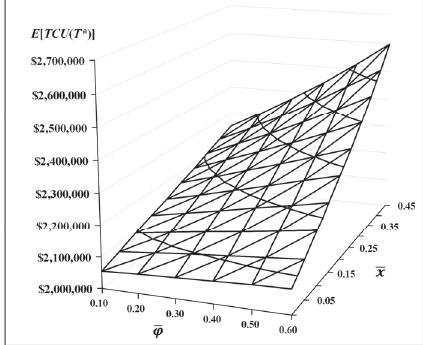
Fig. 11. The behavior of E [ TCU ( T *)] concerning the collective impact from and and x 